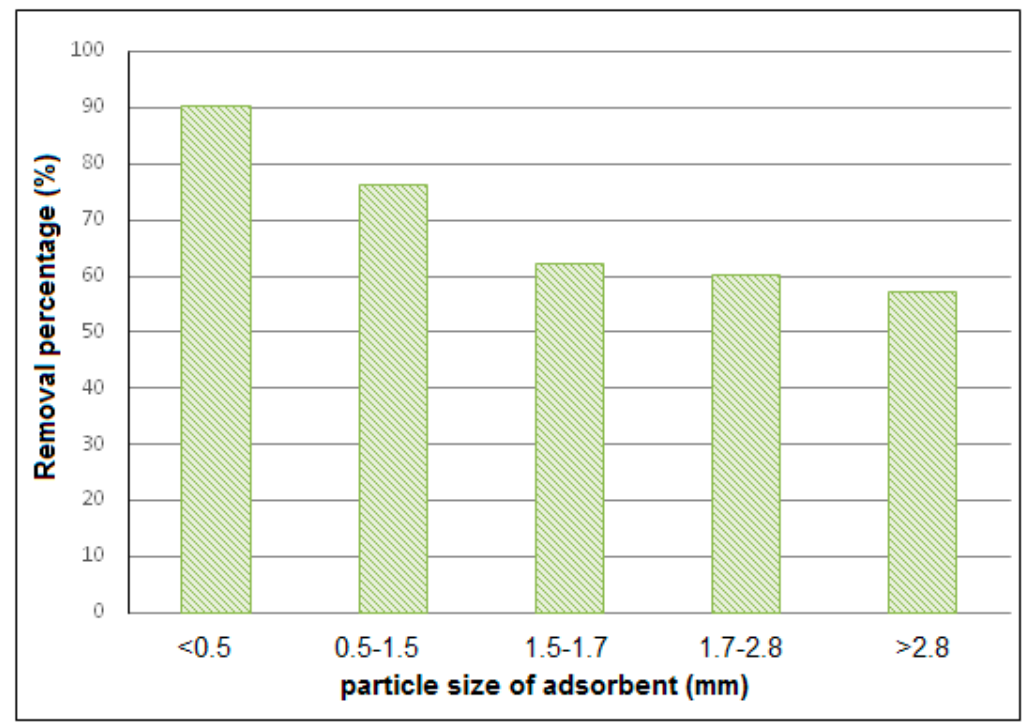
Figure 4. The removal yield of copper from aqueous solution by olive pomace.